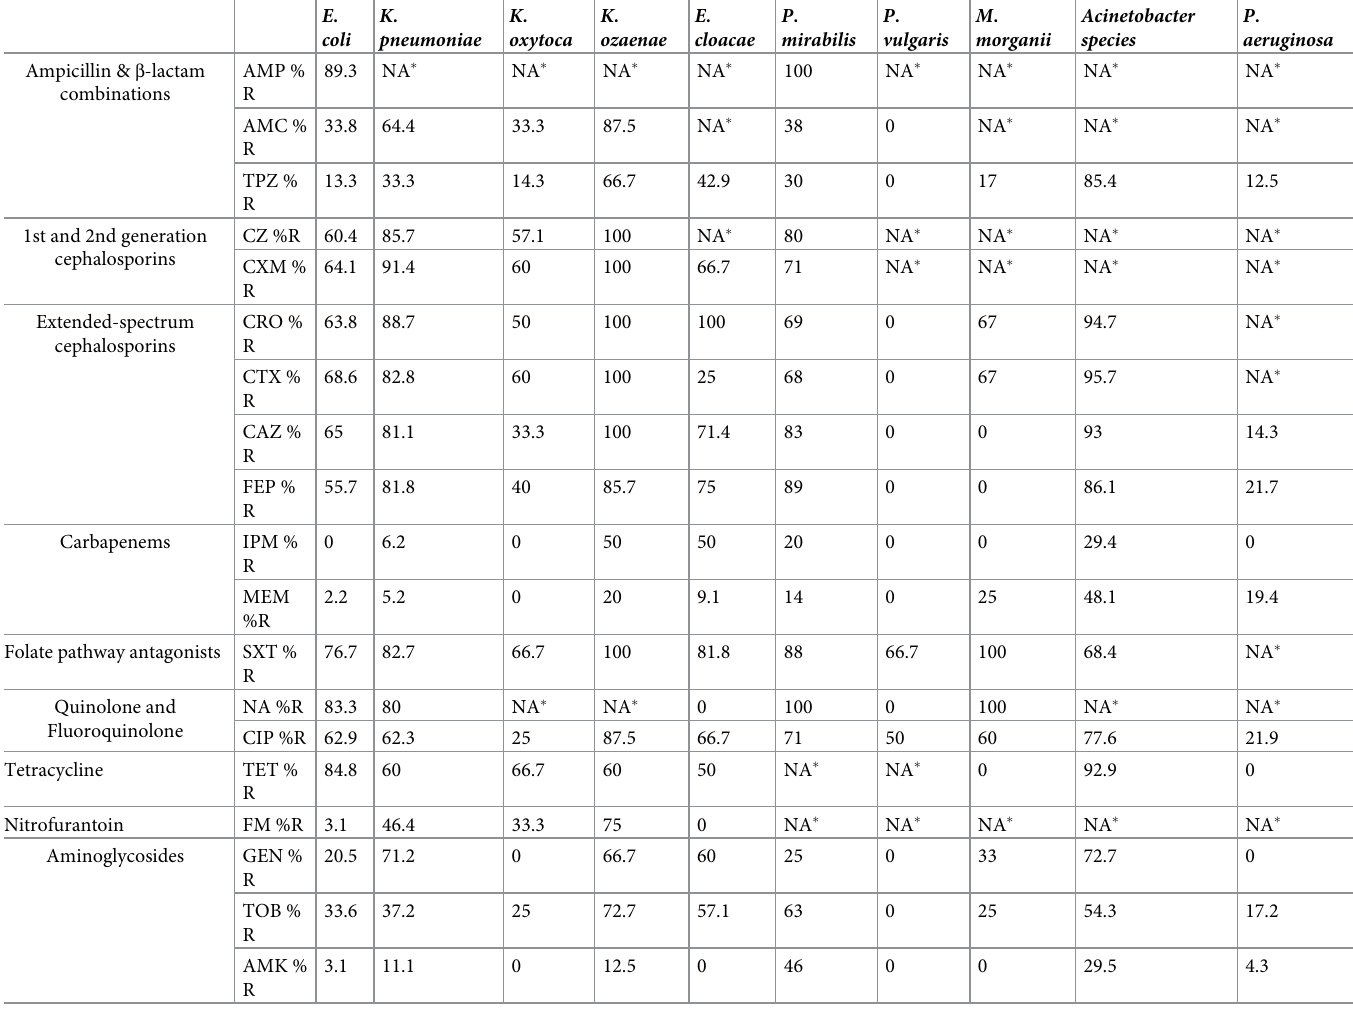
Table 5. Antibiotic susceptibility pattern of gram-negative bacilli against different antimicrobial